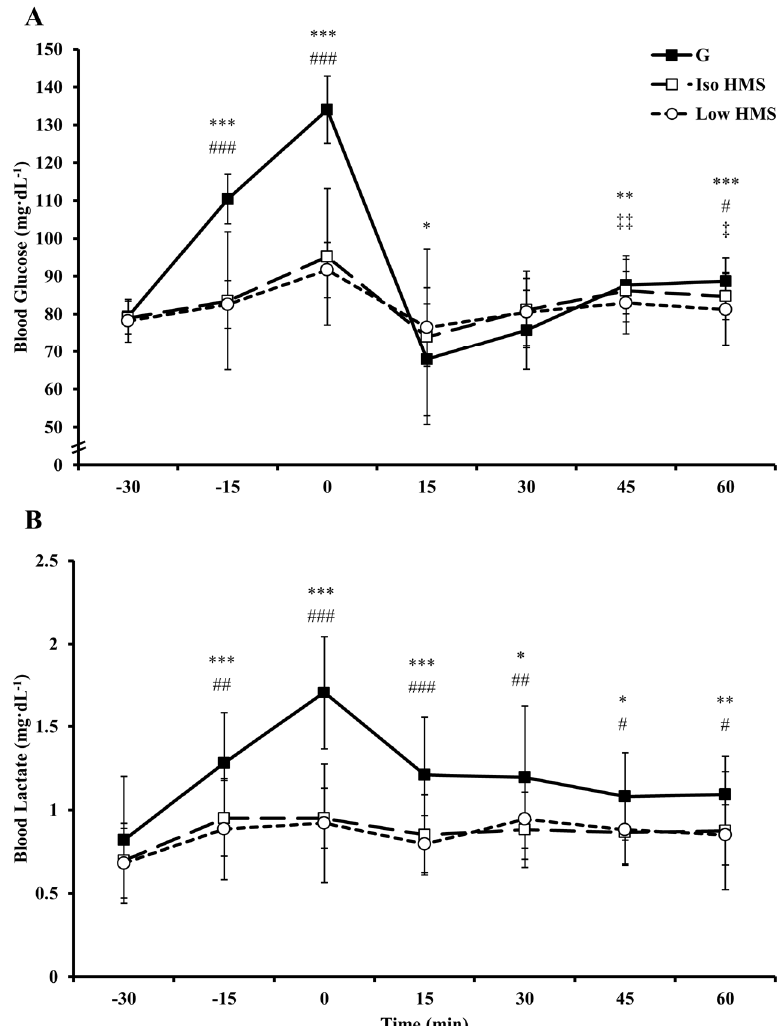
Figure 3. Time course changes in blood glucose and blood lactate. ( A ) Mean blood glucose values; and ( B ) mean blood lactate values. For ( A , B ), bars represent standard deviation. G, a sucrose/glucose supplement; Iso HMS, an isocaloric dose (relative to G) of a hydrothermally ‐ modified starch; Low HMS, low dose of a hydrothermally ‐ modified starch; *** denotes most likely different with G vs. Low HMS; ** denotes very likely different with G vs. Low HMS; * denotes likely different with G vs. Low HMS; ### denotes most likely different with G vs. Iso HMS; ## denotes very likely different with G vs. Iso HMS; # denotes likely different with G vs. Iso HMS; † denotes possibly different with G vs. Iso HMS; ‡‡ denotes very likely different with Iso HMS vs. Low HMS; ‡ denotes likely different with Iso HMS vs. Low HMS.